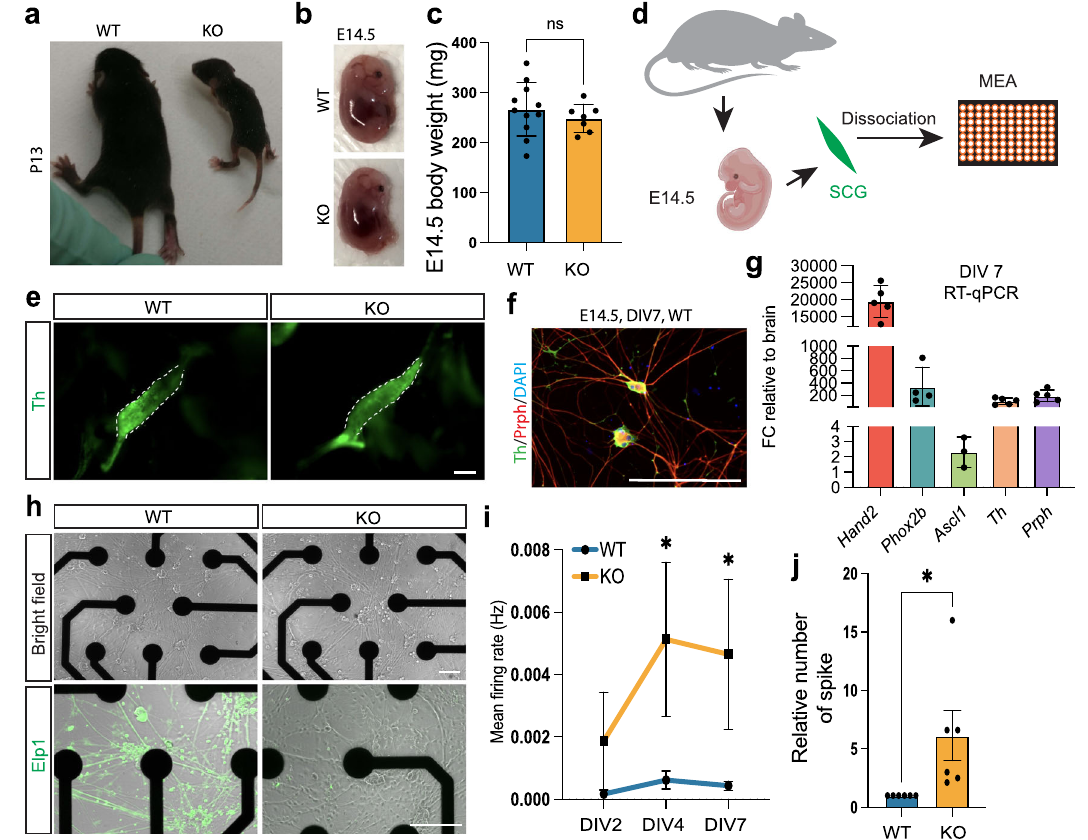
Fig. 3 | Sympathetic neuron hyperactivity in Familial Dysautonomia mouse models. a A survived P13 wnt1 /Sox10-cre; Elp1 LoxP/LoxP -CKO mouse, has reduced body size. b , c E14.5 CKO embryos have no difference in appearance ( b ) as well as in body weight ( c ). n =(WT: 11, KO: 7) biological replicates. Two-tailed Stu- dent ’ s t-test. Error bar represents the SEM. d Schematic illustration of superior cervical ganglia (SCG) neuron culture and experimental design. e Whole mount immunostaining of Th + SCGs shows that E14.5 CKO SCGs have similar size and shape compared to control. f Immunostaining shows Th + (green)/Prph + (red) neurons in culture after one week. g RT-qPCR shows symN gene expressions on day in vitro 7 (DIV7). N =( Hand2 / Th / Prph : 5, Pho2b : 4, Ascl1 : 3) biological